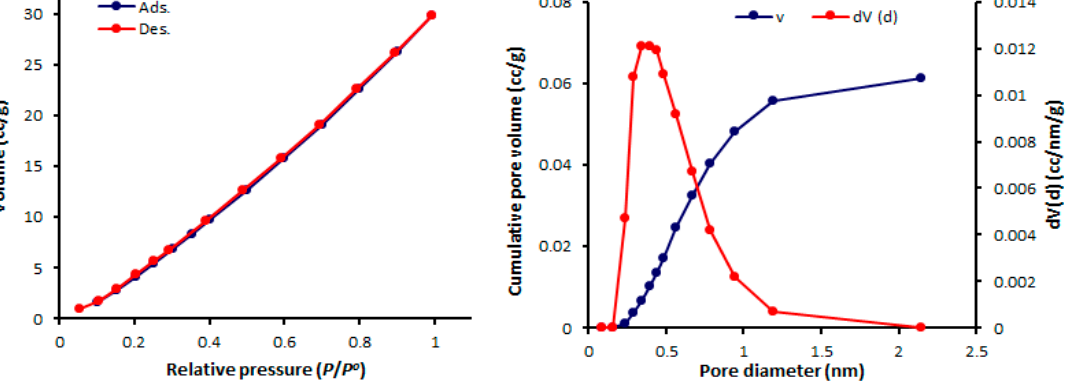
Figure 4. N 2 isotherms and pore diameters of 1 .